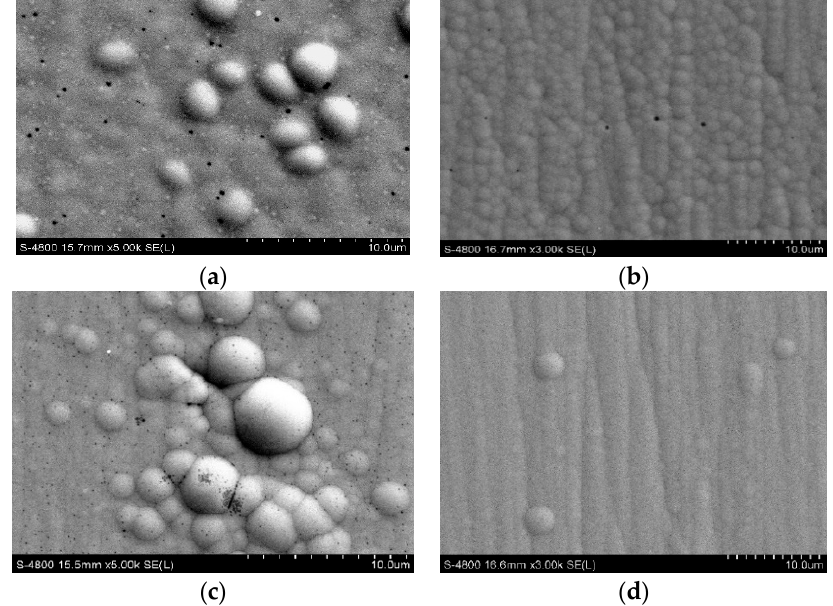
Figure 5. Morphology (SEM images) of Fe-P coatings electrodeposited at various Gly concentrations and current densities, j , at 60 °C. ( a ) Fe-12 at.% P ( j e = 15 mA cm − 2 , c [Gly] = 0.11 M); ( b ) Fe-13 at.% P ( j e = 30 mA cm − 2 , c [Gly] = 0.11 M); ( c ) Fe-14 at.% P ( j e = 15 mA cm − 2 , c [Gly] = 0.64 M); and ( d ) Fe-16 at.% P ( j e = 30 mA cm − 2 , c [Gly] = 0.64 M).